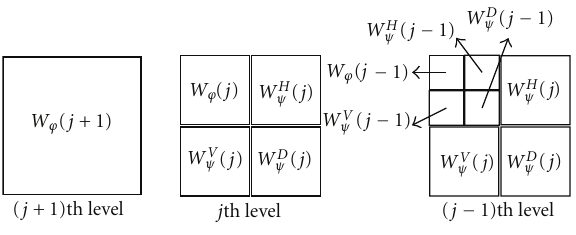
Figure 3: 2D wavelet decomposition.